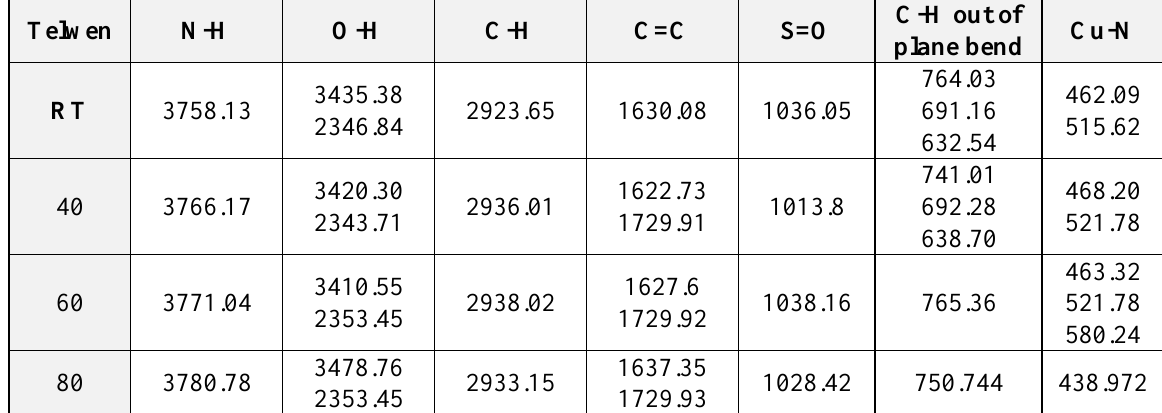
Table 4: FTIR bond for CuPcTs:BEDOT/PSS thin films chemically treated with talwen at different time. N-H O-H C-H C=C S=O